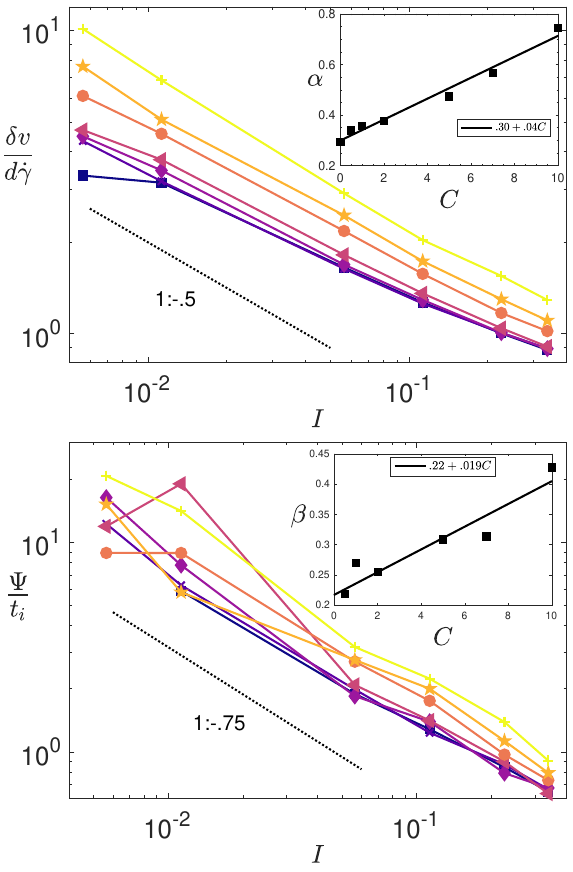
Figure 3. Velocity fluctuation δv (a) and their time persistence Ψ (b) measured in flows with di ff erent inertial numbers I and cohe- sion number C .The dashed lines represent a power low with an exponent − 0 . 5 and − 0 . 75 for visual reference. Symbols repre- sent di ff erent levels of cohesion as per figure 2. Insets show the coe ffi cient α and β obtained by fitting the data with Eq. (8), as well as linear fits for α ( C ) and β ( C ) (solid